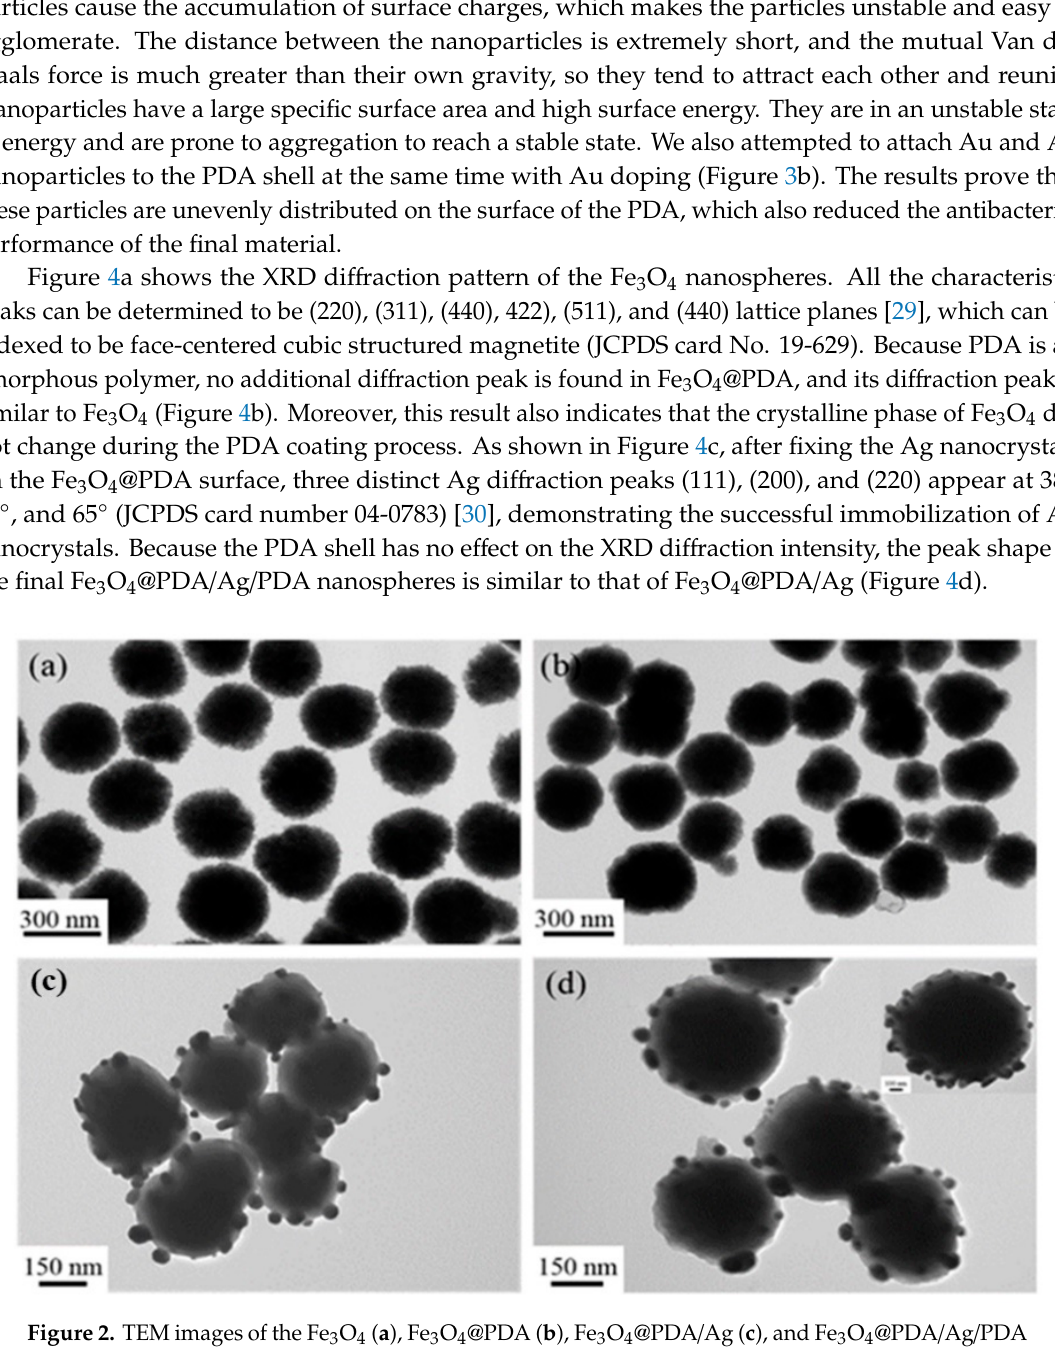
Figure 2. TEM images of the Fe 3 O 4 ( a ), Fe 3 O 4 @PDA ( b ), Fe 3 O 4 @PDA/Ag ( c ), and Fe 3 O 4 @PDA/Ag/PDA ( d ) nanospheres.